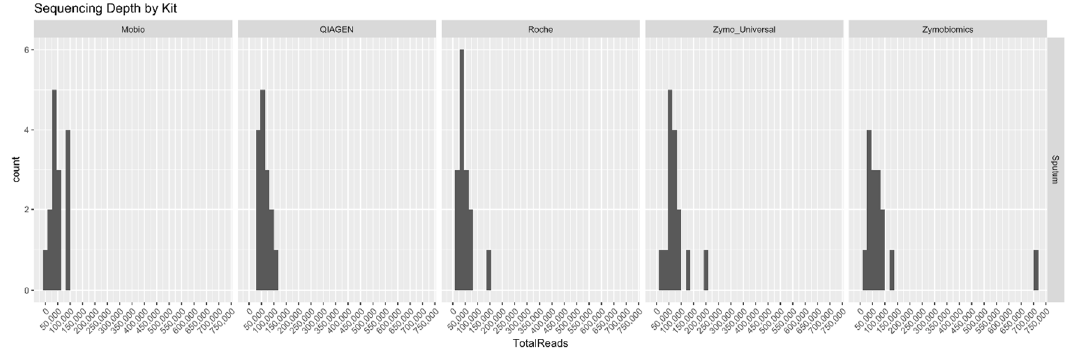
Figure 4. Sequencing depth of samples by kit.